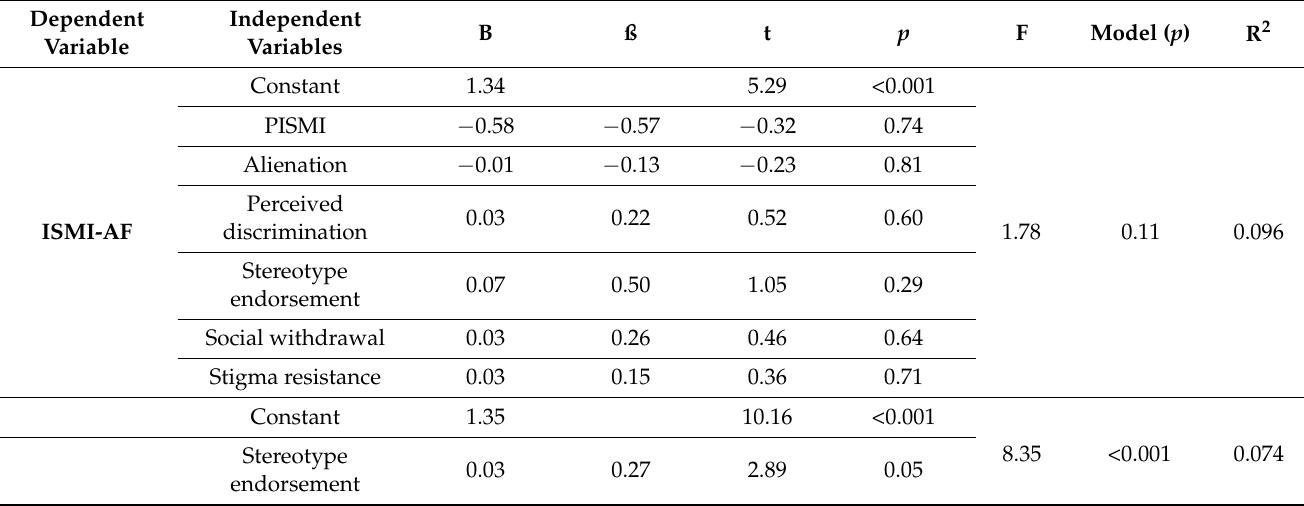
Table 4. The effect of PISMI totals and subscales on the